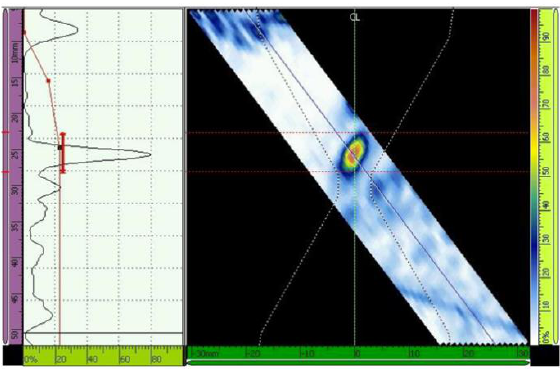
Figure 14. Time correct gain adjustment. Scanning angle of 45°, 16 active elements. Primary gain = 22.8 dB.